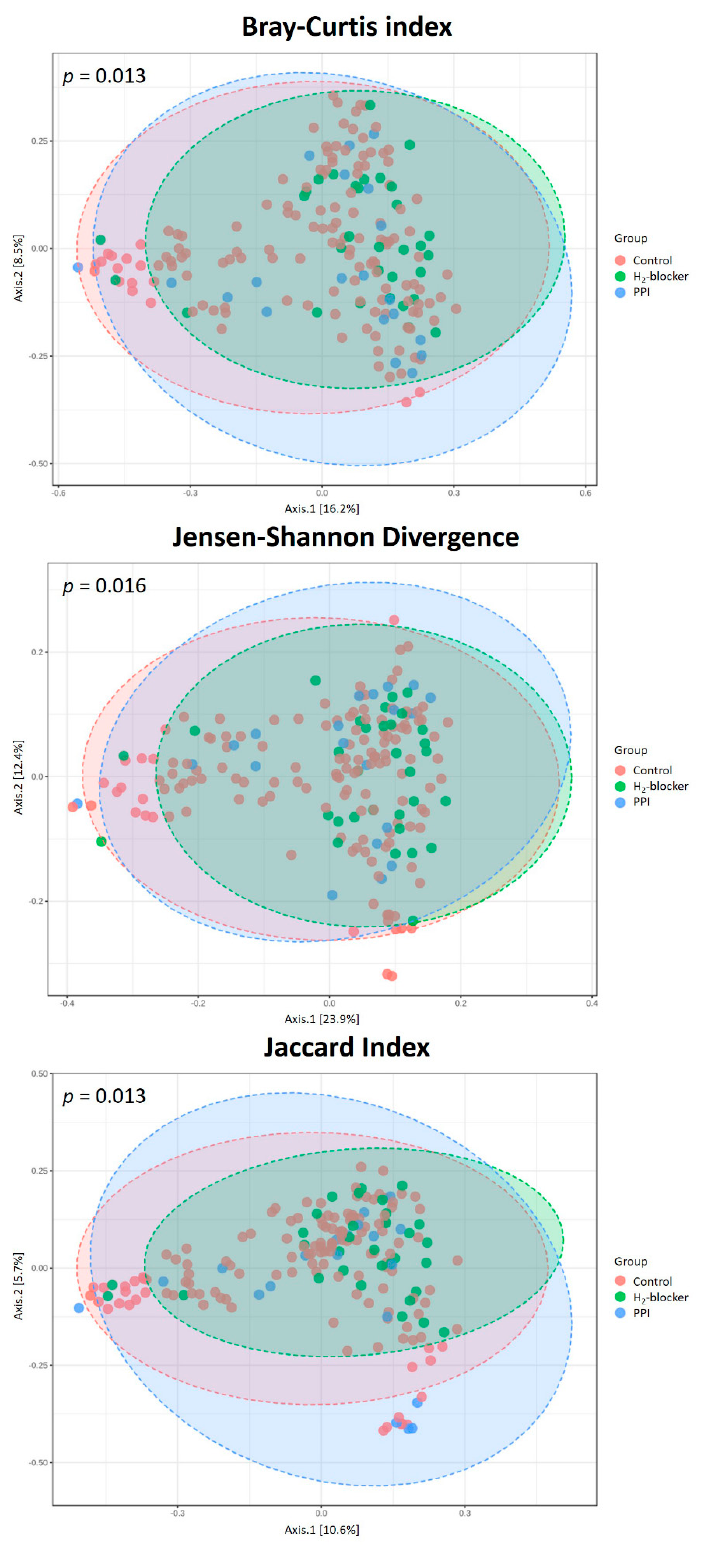
Figure 2. The β -diversity in hemodialysis patients with proton pump inhibitor users, H 2 -blocker users, and controls (Bray–Curtis index, Jensen–Shannon divergence, and Jaccard index). Differences in β -diversity were tested by permutational multivariate analysis of variance using distance matrices (PERMANOVA).